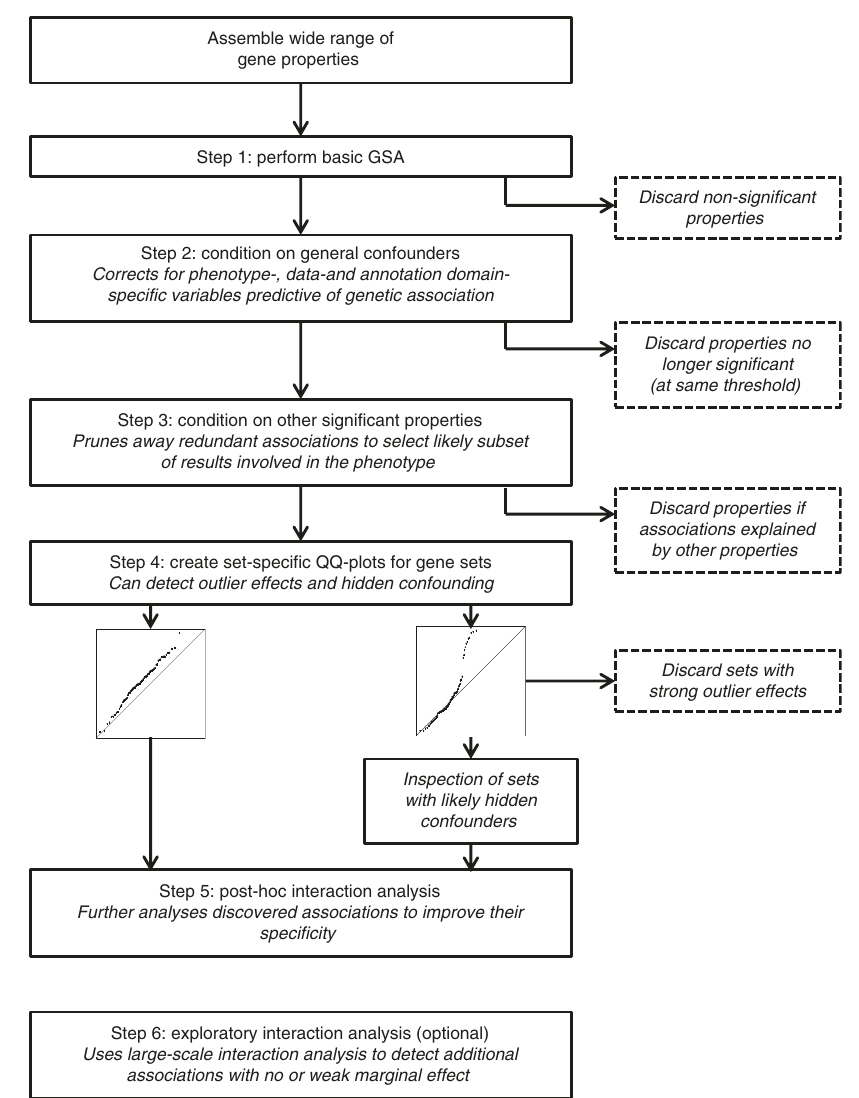
Fig. 2 Overview of the extended gene-set analysis work fl ow. The work fl ow is composed of fi ve steps, starting with a standard gene-set analysis in step one. Results from this analysis are then successively re fi ned in the subsequent steps, discarding initially signi fi cant gene properties if their associations are found to be insuf fi ciently robust. In the optional sixth step an exploratory interaction analysis is used to detect additional interaction effects not